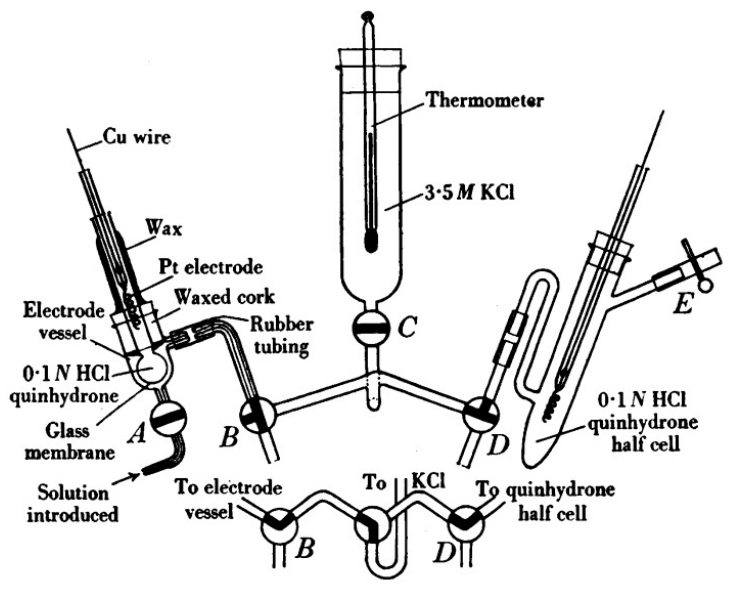
Figure 4. The design of glass electrode measurement, reprinted with permission from reference [57]. (Copyright, Portland Press, 1933).